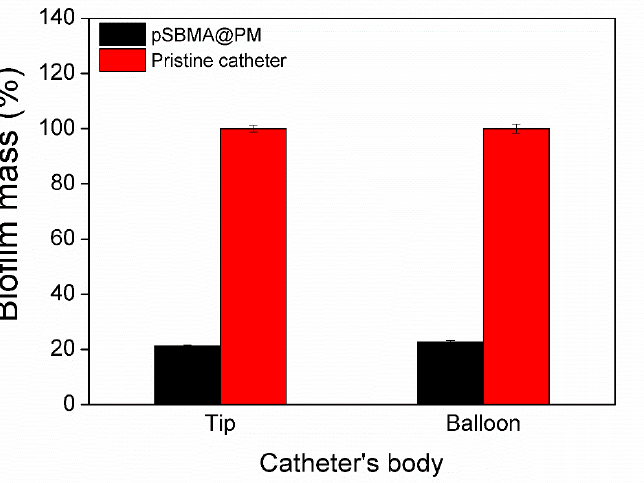
Figure 5 . In vitro biofilm inhibition tests in catheterized bladder model with artificial urine recirculation. Total biofilm quantification of P. aeruginosa biofilm mass on pSBMA@PM-coated urinary catheters.